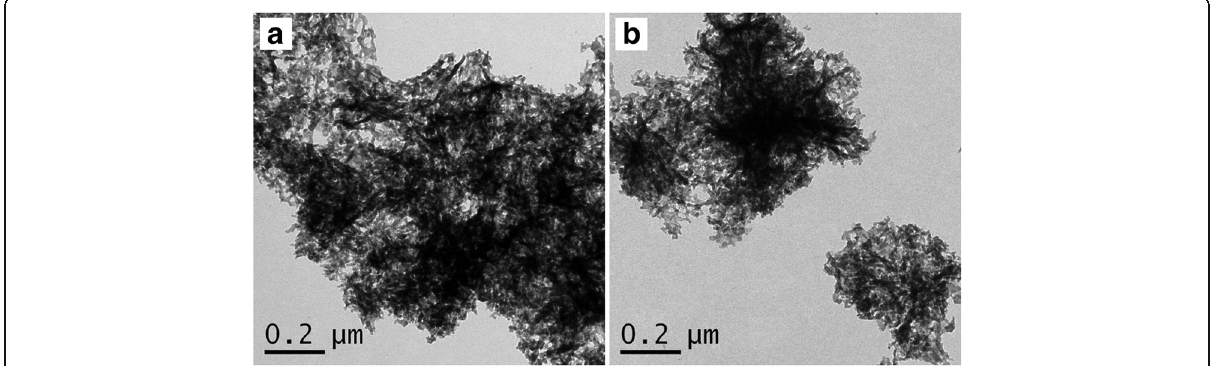
Fig. 6 TEM images of SA-Zn-HZ-Pb ( a ) and SA-Zn 3 Al-HT-Pb ( b